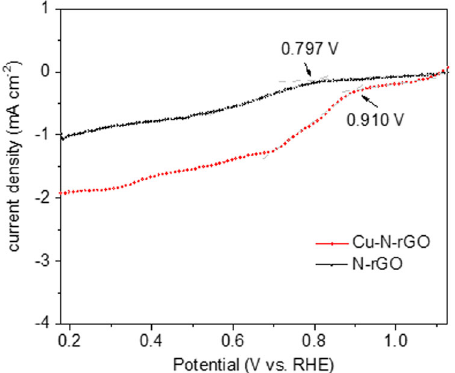
Fig. 7 Linear sweep voltammetry analysis. Linear sweep voltam- mograms on graphene-based catalysts in air-saturated 0.1 M KOH solution.